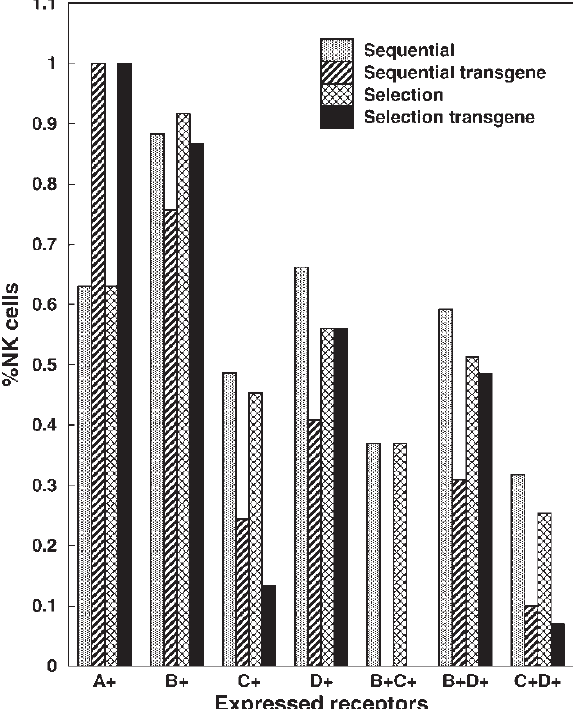
FIGURE 2 Predicted effect of a self-MHC receptor transgene, (A), on the frequencies of NK cells expressing other inhibitory receptors according to the two education models, for the case of four receptor genes: A - self, p A ¼ 0 : 27 ; A A ¼ 2 ; B - self, p B ¼ 0 : 62 ; A B ¼ 2 ; C - self, p C ¼ 0 : 2 ; A C ¼ 1 ; D - non-self, p D ¼ 0 : 56 ; A D ¼ 0 ; A min ¼ 3 ; A max ¼ 4 :